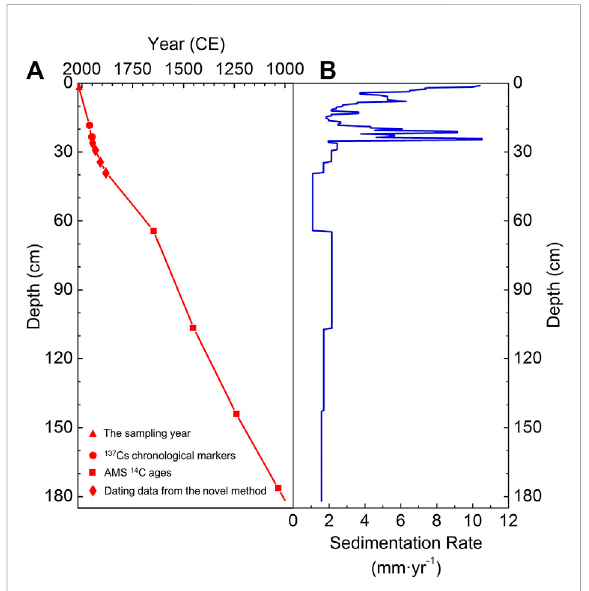
FIGURE 6 (A) Age-depth and (B) sedimentation rate-depth plots of the connected GH19C-J